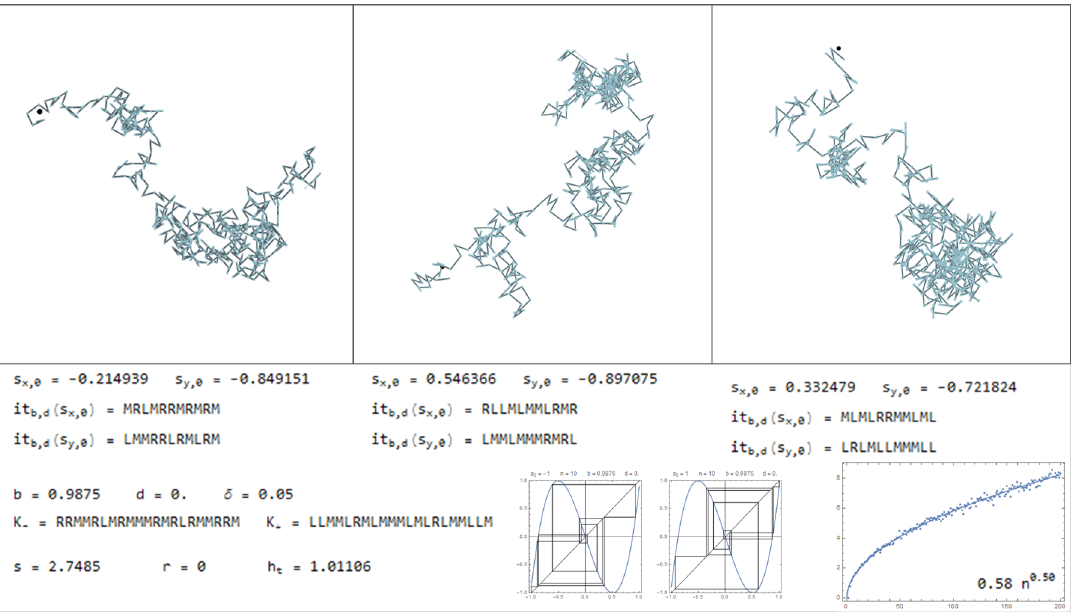
Figure 13. Trajectories produced with b = 0.9875 and d =